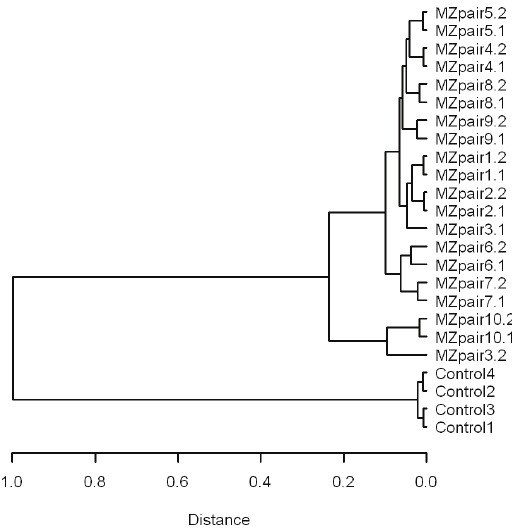
Figure 4. Cluster dendrogram of all twin and control samples. From left to right, the first two branches separate the control samples (HapMap cell line DNA) from the buccal samples from twins.